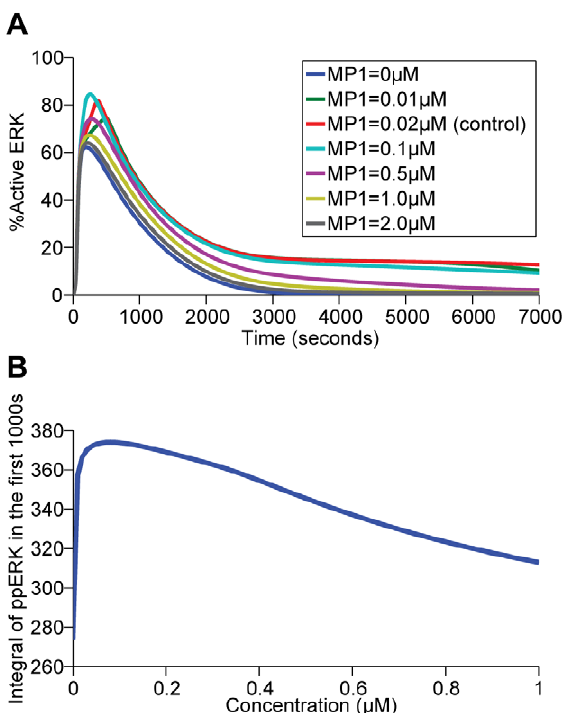
Figure 6. The biphasic effect of MP1 on ERK activation. (A) Percentage of active ERK was plotted over the period indicated by varying the concentrations of MP1 from 0 to 2 m M. (B) Existence of an optimal scaffold concentration of MP1 (0.1 m M) by plotting the time integral of ppERK/ERK in the first 1000 seconds and MP1’s initial concentrations.